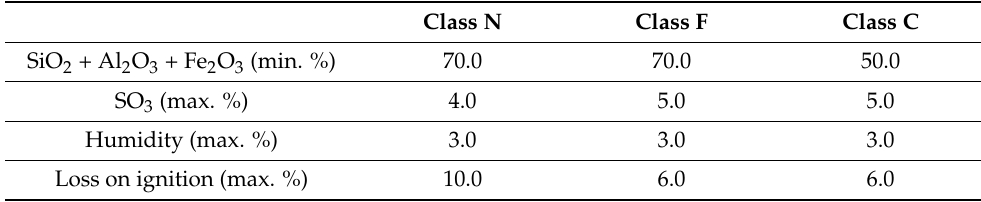
Table 1. Chemical composition requirements for fly ash classifications (based on